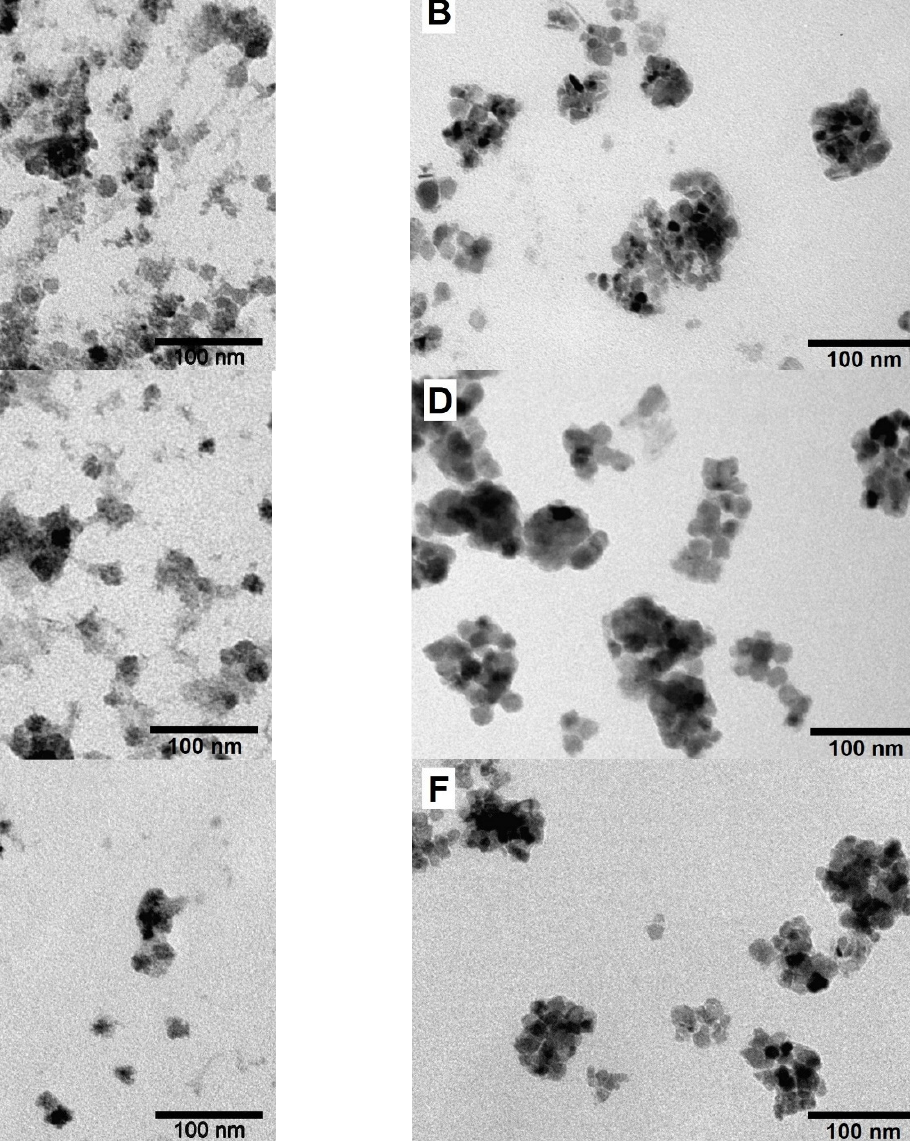
Figure 7. TEM images for x = 0.0-BT, x = 0.5-BT, and x = 1.0-BT samples after hydrothermal synthesis ( A , C , E , respectively) and after annealing and ball milling ( B , D , F , respectively). The samples after the annealing were studied by XRD and using magnetic measure- consist of barium titanate (PDF Card No.: 01-075-1606), ferrite phase, and barium carbonate (PDF Card No.: 01-078-4343) phases (Figure 8, Table 1). The last phase exists